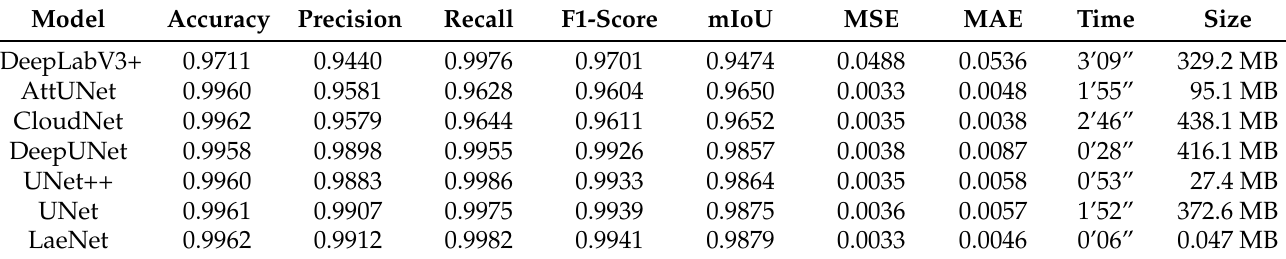
Table 3. Performance on different semantic segmentation